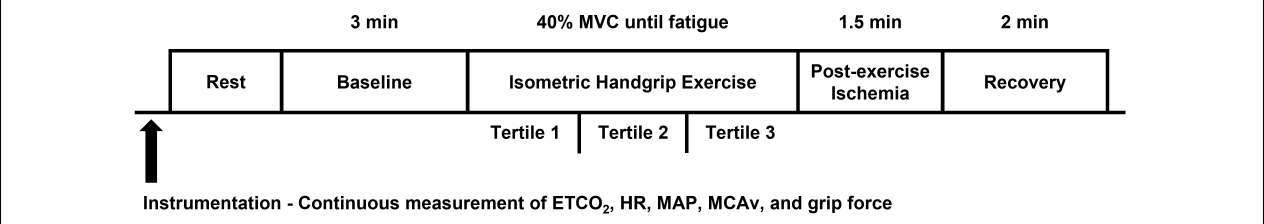
Frontiers in Aging Neuroscience |